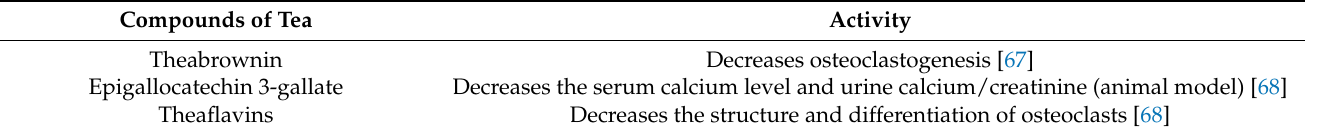
Table 2. Impact of tea compounds on the